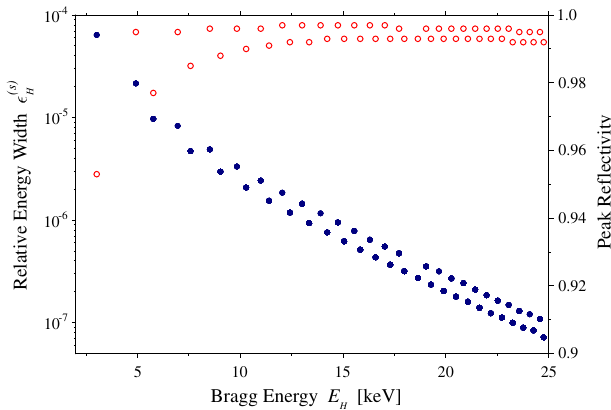
FIG. 5. (Color) Closed circles: relative energy width (cid:5) ð s Þ H of all allowed Bragg reflections in diamond (C) crystals, in the sym- metric scattering geometry, for Bragg energies E H up to 25 keV. Open circles: the same for the peak reflectivity. Calculations are performed with dynamical theory of x-ray diffraction in thick crystals as described in [11]. Debye-Waller factors are calculated using 2200 K Debye